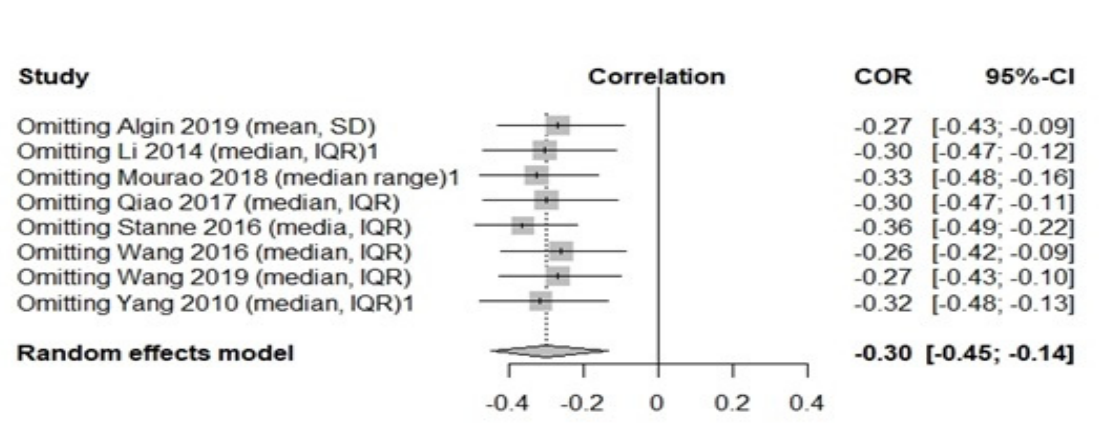
Figure 4. Sensitivity analysis serum BDNF and NIHSS.